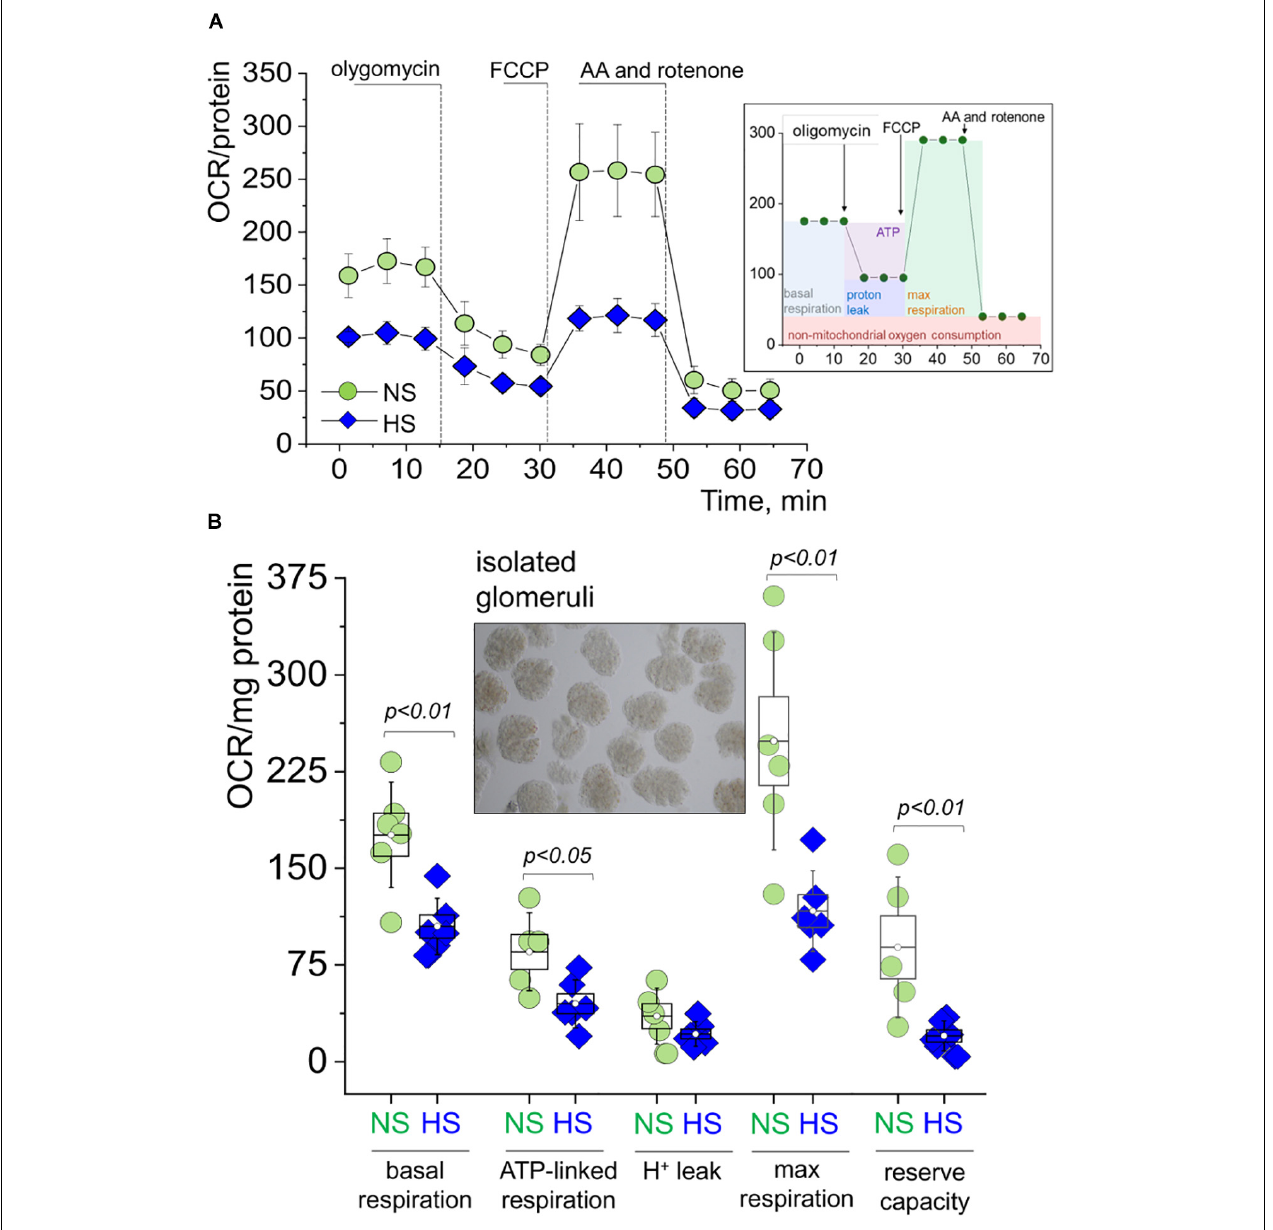
FIGURE 4 | Mitochondrial respiration in the freshly isolated glomeruli during SS hypertension. (A) Oxygen consumption rate (OCR, pmol/min/mg protein) values obtained in a Seahorse experiment from glomeruli freshly isolated from the renal cortex of rats fed a high salt (HS) or normal salt (NS) diet. Shown are curves summarized from at least five rats per group, three to five replicates per rat; error bars are SEM. Right inset panel illustrates the experimental design. (B) Summary for basal respiration, ATP production, proton leak, maximal respiration, and reserve respiratory capacity as measured in the seahorse experiment shown in Graph. OCR is expressed in pmol/min/mg protein (A) . Each data point is an average of at least three replicates per individual rat. An inset shows a typical preparation of isolated glomeruli. All data were compared using a one-way ANOVA with Holm–Sidak post hoc test. NS, normal salt; HS, high